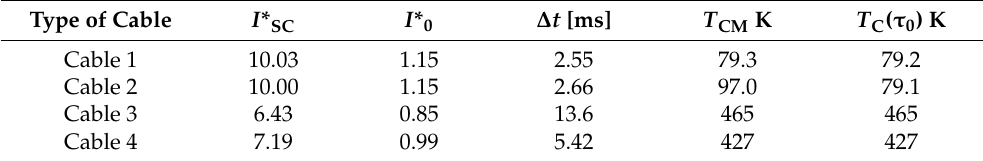
Table 1. Results of calculations of the short-circuit mode characteristics in HTS power transmission lines with HTSF connected according to the schematic diagram of Figure 1. The initial data for calculations are the same as in Table 1. The cable length is 50 m. The designations are the following: I * SC = I SC / I L is the dimensionless surge current; I * 0 = I 0 / I L is the amplitude of the current established after the destruction of the fuse box HTS, ∆ t is the time interval from short-circuit starting to the moment of the fuse box, destruction T CM is the maximum cable temperature, T C ( τ 0 ) is the cable temperature to the moment of the circuit breaker actuation ( τ 0 = 0.125